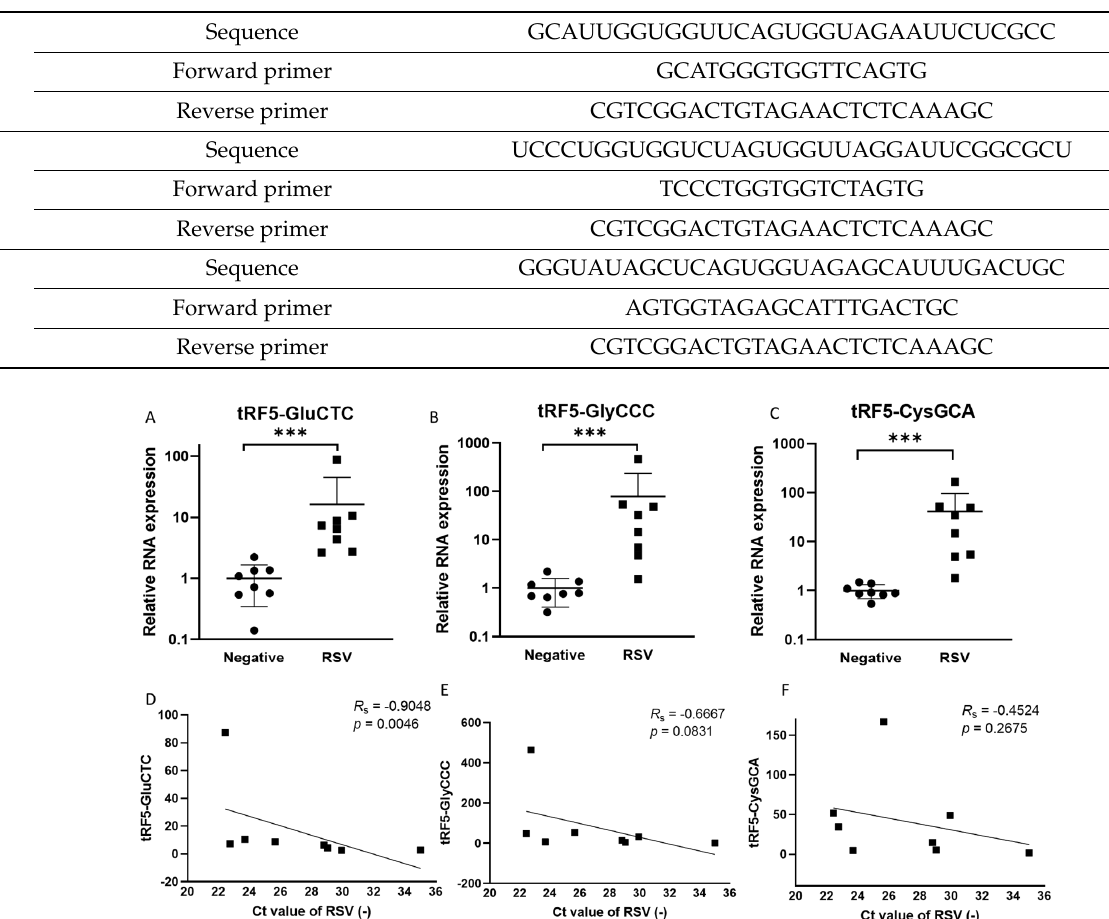
Table 2. Primer information to detect tRF5s using qRT-PCR.